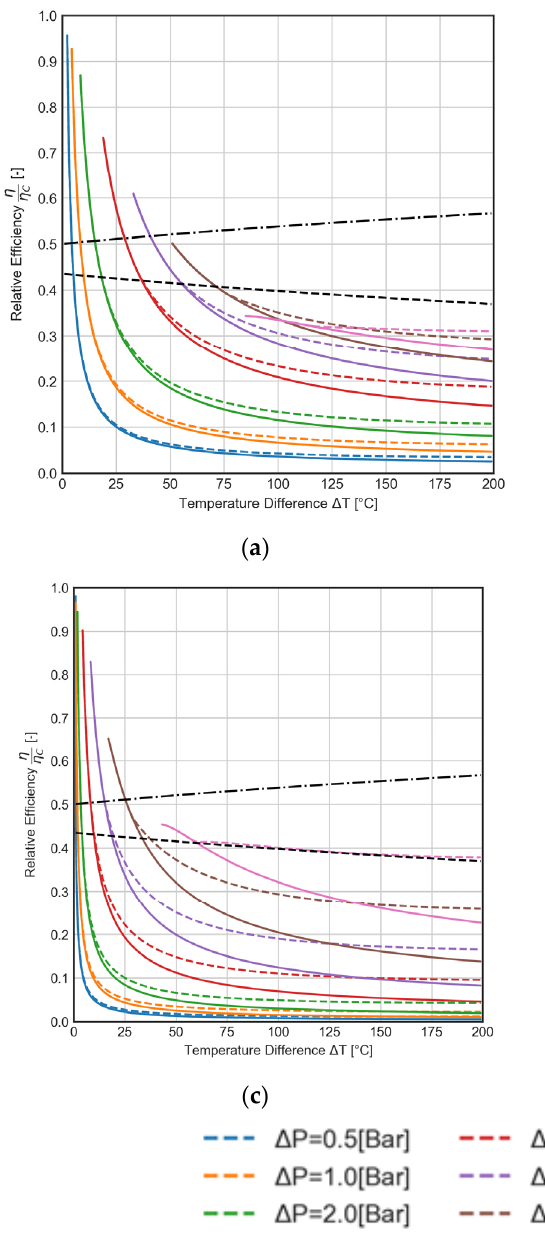
Figure 6. Specific efficiency of pure working fluids: ammonia ( T L = 10 ◦ C, P L = 6.15 bar) ( a ), water ( T L = 90 ◦ C, P L = 0.70 bar) ( b ), CO 2 ( T L = 10 ◦ C, P L = 11.07 bar) ( c ), acetone ( T L = 46 ◦ C, P L = 0.71 bar) ( d ). Solid line = without heat regeneration, dashed line = with heat regeneration.